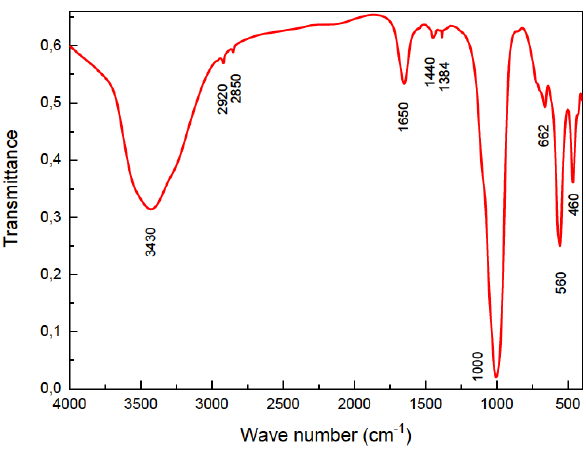
Figure 3: FTIR spectra of the as-synthesized LTA zeolite powders.